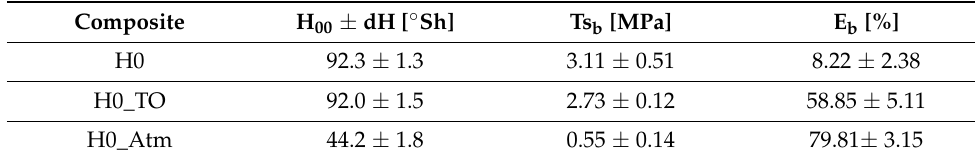
Table 7. Mechanical results for degraded samples.